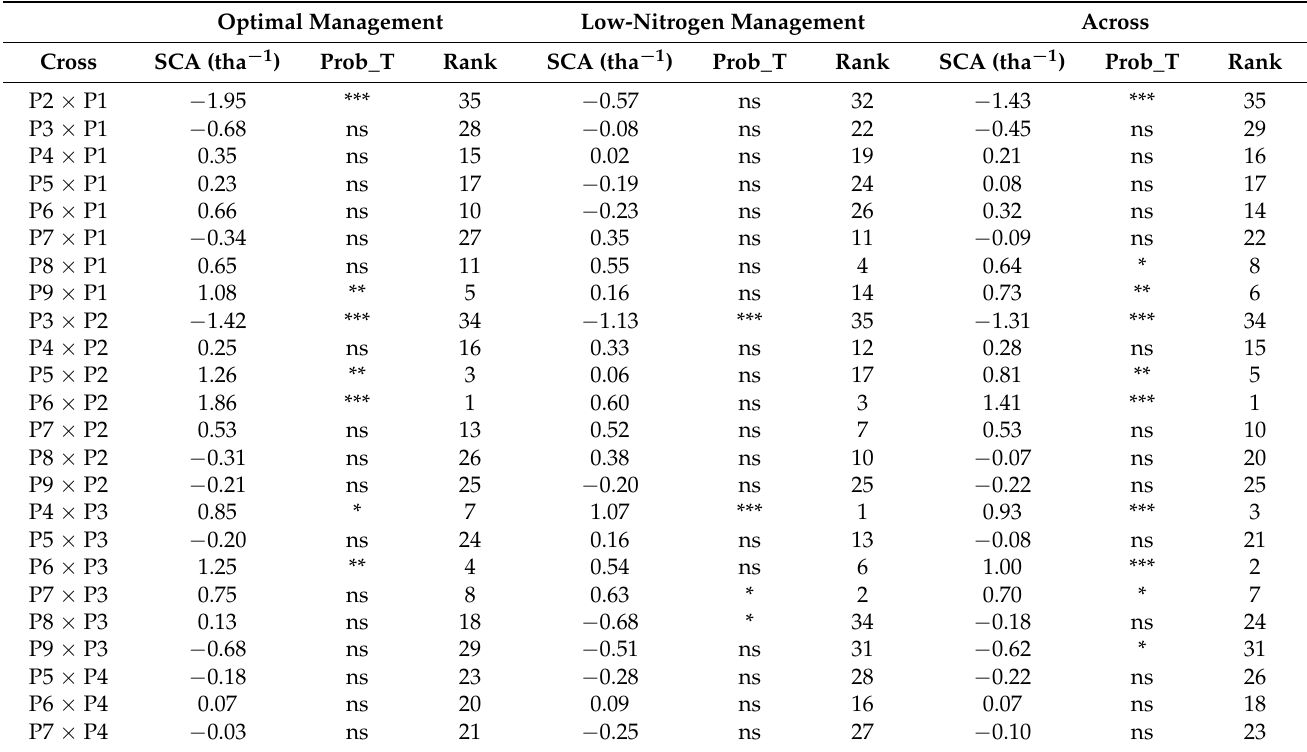
Table 5. The specific combining ability (SCA) effects of new and elite CIMMYT lines evaluated under low-nitrogen and optimal conditions in Zimbabwe and Zambia during the 2018 and 2019 summer